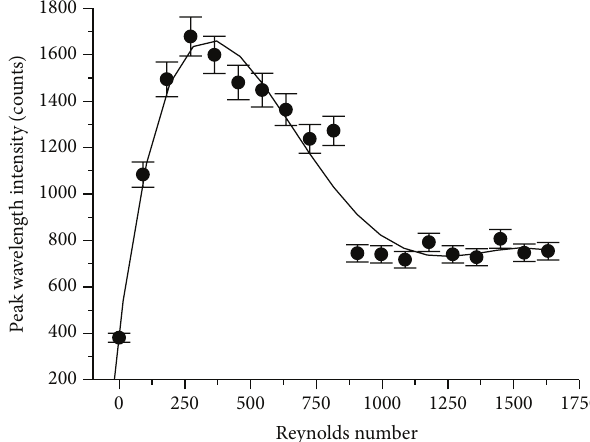
Figure 2: The spectral intensity variation of the emission data [24] and fitted function with the Reynolds numbers of the liquid